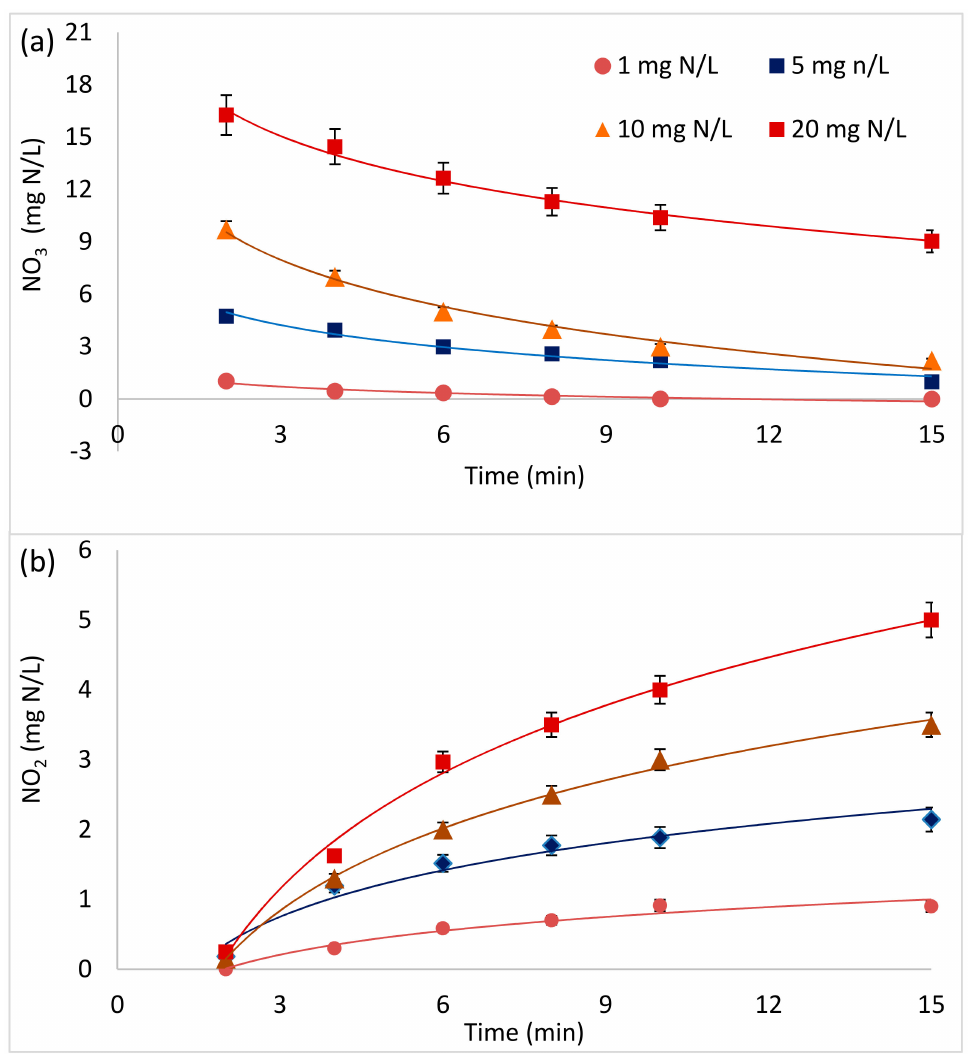
Figure 4. The nitrate decay ( a ) and nitrite formation ( b ) at different initial NO 3 −